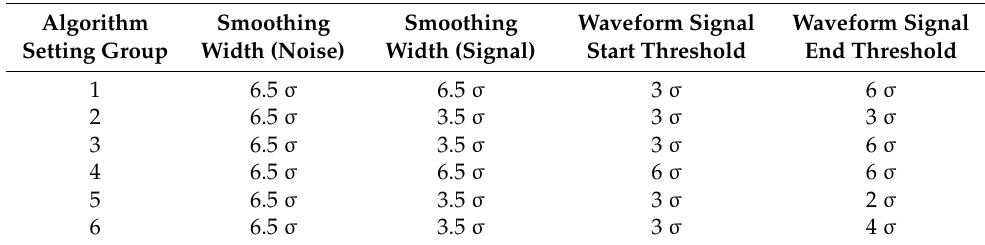
Table 1. GEDI L2A product algorithm setting groups. σ is the standard deviation of the background noise level of the received